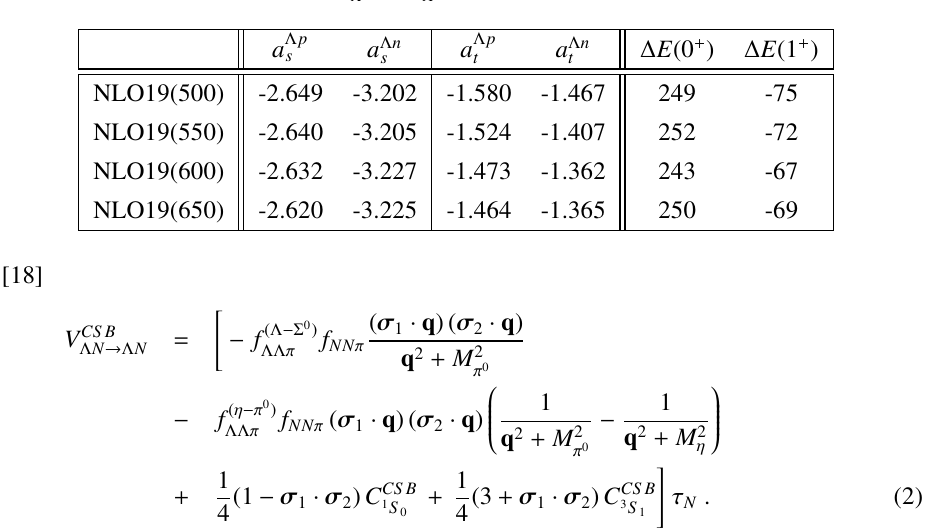
Table 1. Λ p and Λ n scattering lengths (in fm) in the singlet and triplet S waves for the NLO19 potential, for cuto ff s of 500-650 MeV. In addition, the resulting level splittings for the A = 4 mirror nuclei 4 Λ H and 4 Λ He (in keV) are